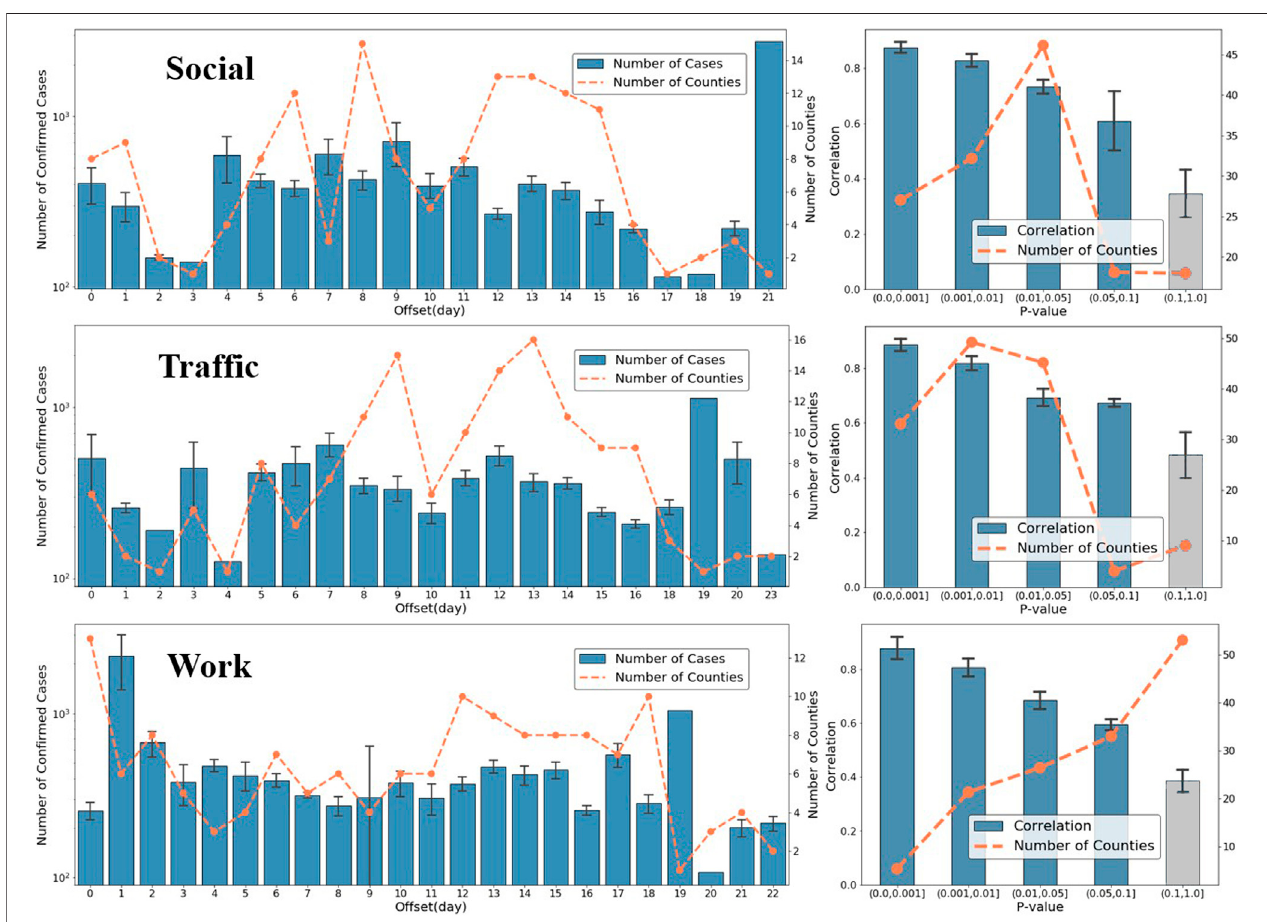
FIGURE 7 | The time-lagged correlation analysis result between activity density ( D a ) change and reproduction number ( R 0 ). The left column shows the number of cases and the number of counties for different offset days, and the right column shows the correlation index and the number of counties with different p -value intervals. Each row presents one of the three tile activity categories: social, traf fi c, and work.